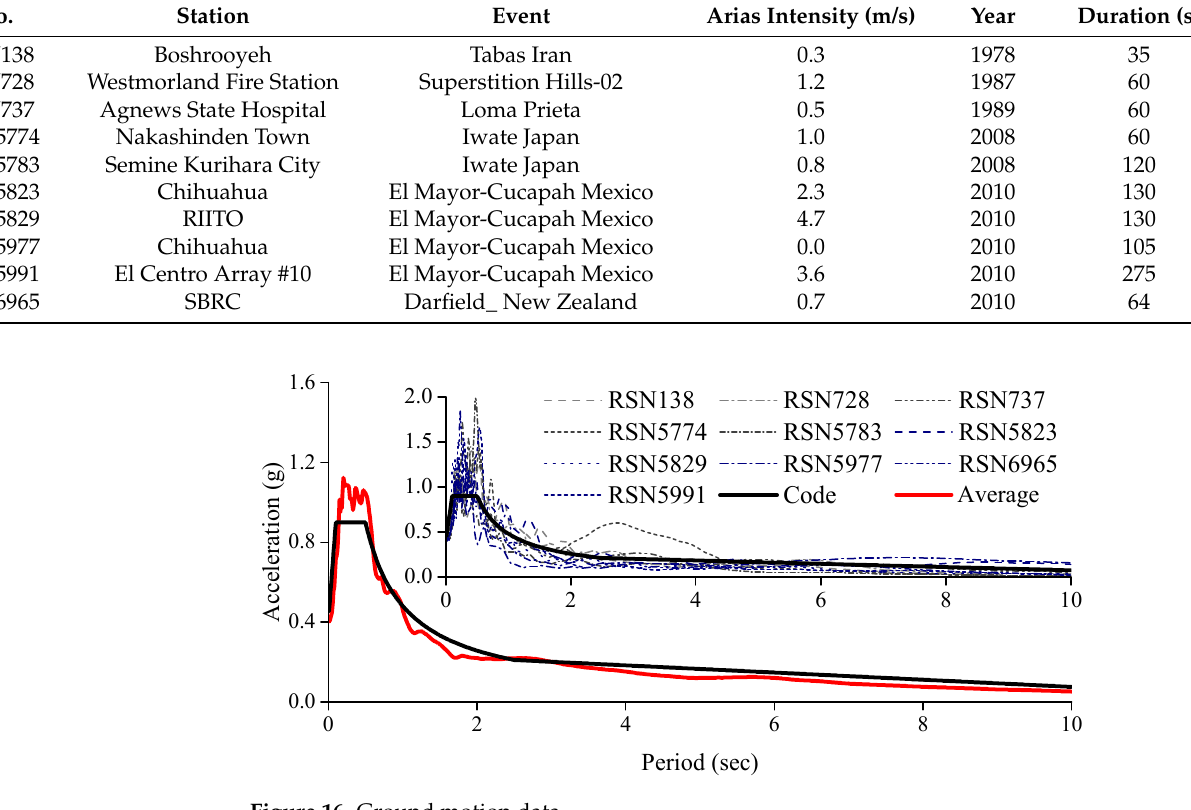
Figure 16. Ground motion data.